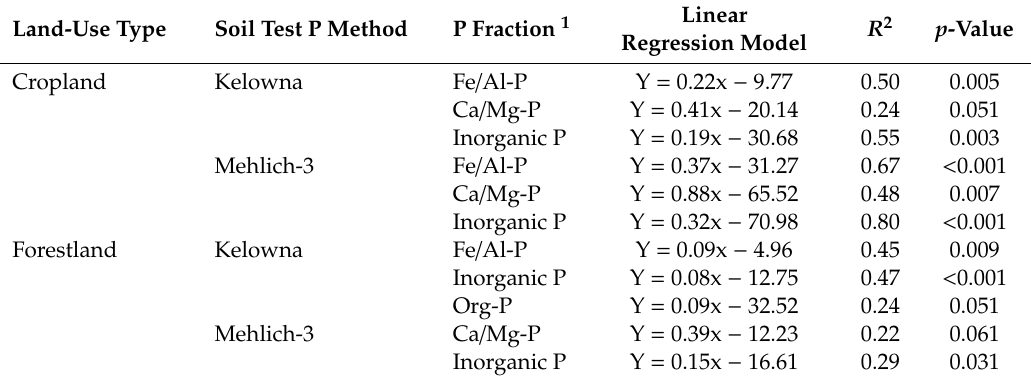
Table 4. Linear regression models that describe the modified Kelowna and Mehlich-3 extractable P (Y) as a function of P fractions (X) over the 0–30 cm depth in cropland and forestland in shelterbelt systems ( n = 6).